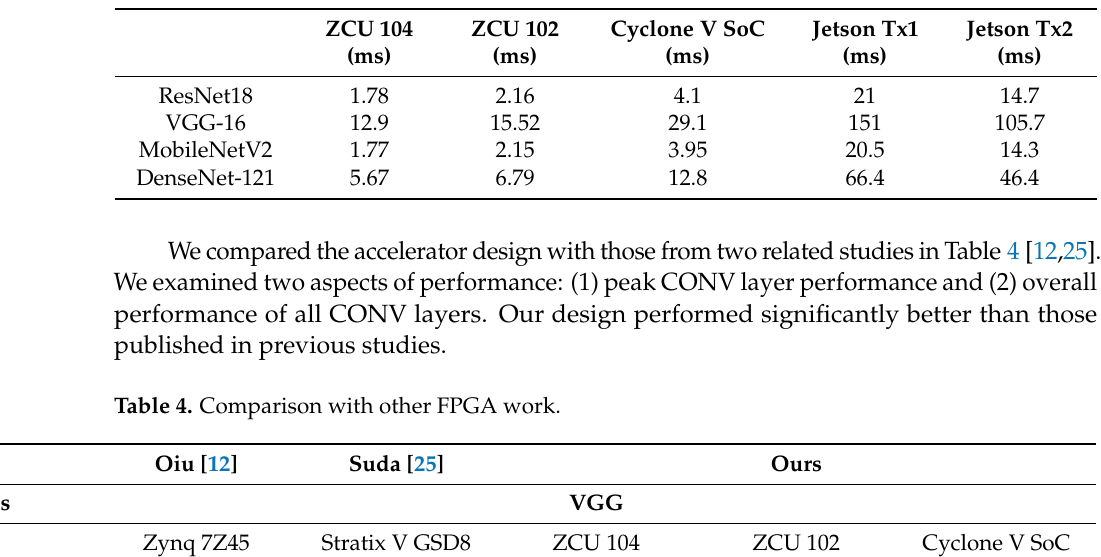
Table 3. Evaluation on FPGA (batch size = 1 for Fix16).